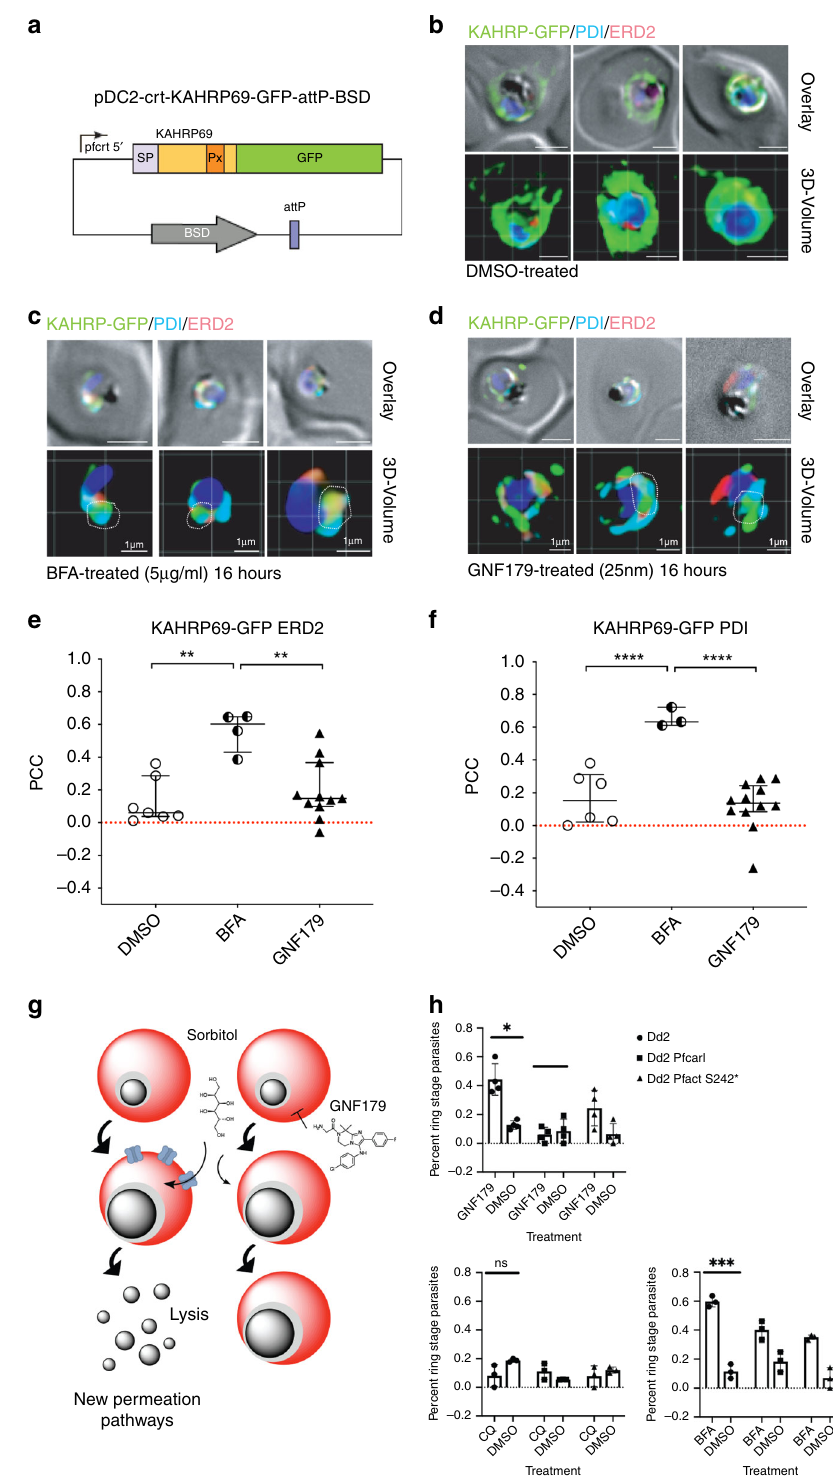
anti-PDI antibody (cyan) (Fig. 4c, f) or by using ER tracker (red) (Supplementary Fig. 5c, f). The white dotted outlines indicate overlap of green and cyan labels. We also observed some colocalization between the GFP and ERD2 signal (Fig. 4c, e) under brefeldin A treatment, though this correlation is lower than what is seen between GFP and PDI. Interestingly, treatment with 5x IC 50 GNF179 (25 nM) for 16 hours did not show signi fi cant colocalization of the GFP signal with either